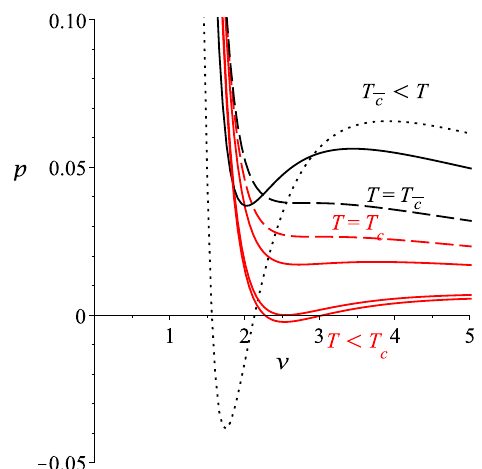
Figure 21 . p (cid:0) v graph illustrating two (cid:12)rst order phase transitions . The behaviour of pressure versus volume for temperatures less than (cid:12)rst critical point T = T c presented with dashed red line, i:e:; T = 0 : 45 T c ; : 48859 T c ; 0 : 8 T c (red lines) and temperatures larger than second critical point T = T c presented with dashed black line, i:e:; T = 1 : 5 T c ; 1 : 9 T c (black lines). Here, we set (cid:22)=e 4 = 3 = (cid:0) 0 : 0655 giving T c e 1 = 3 = 0 : 24730 and T c e 1 = 3 (cid:25) 0 :